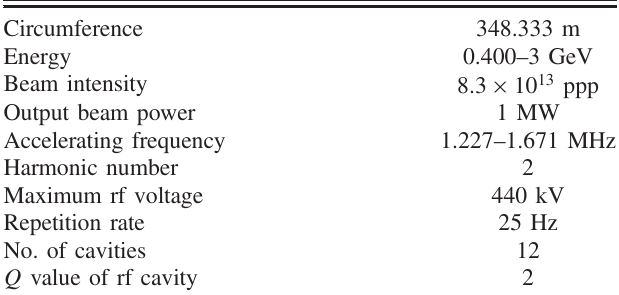
TABLE I. Parameters of the J-PARC RCS and its rf